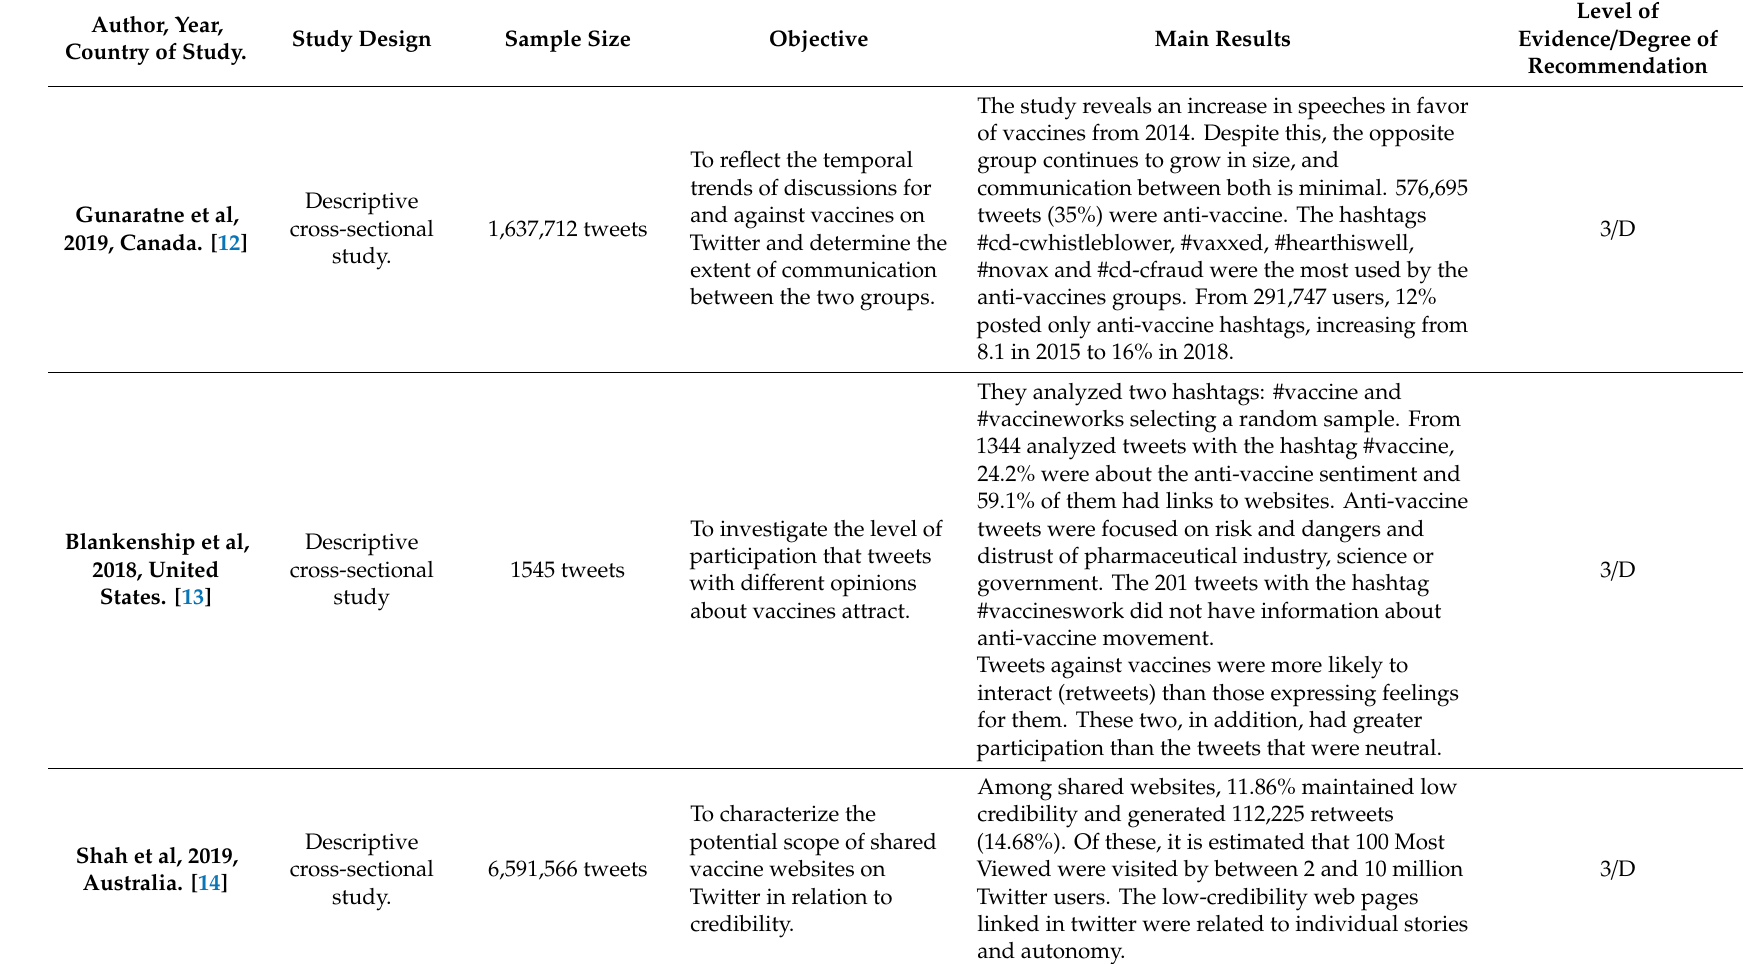
Table 1. Summary of included studies ( N =